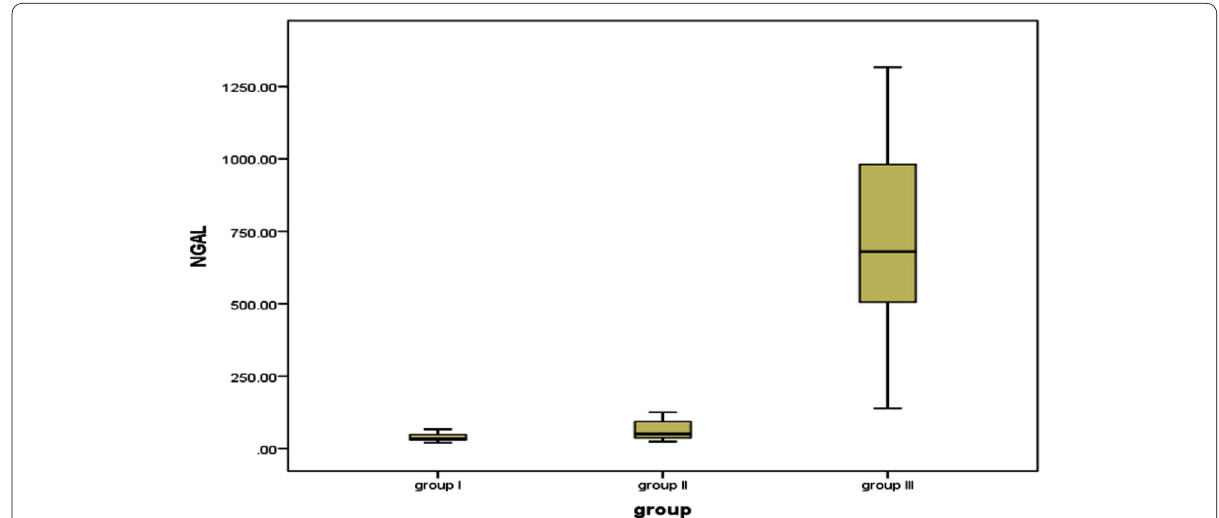
Fig. 1 Box plot of urinary NGAL levels according to study